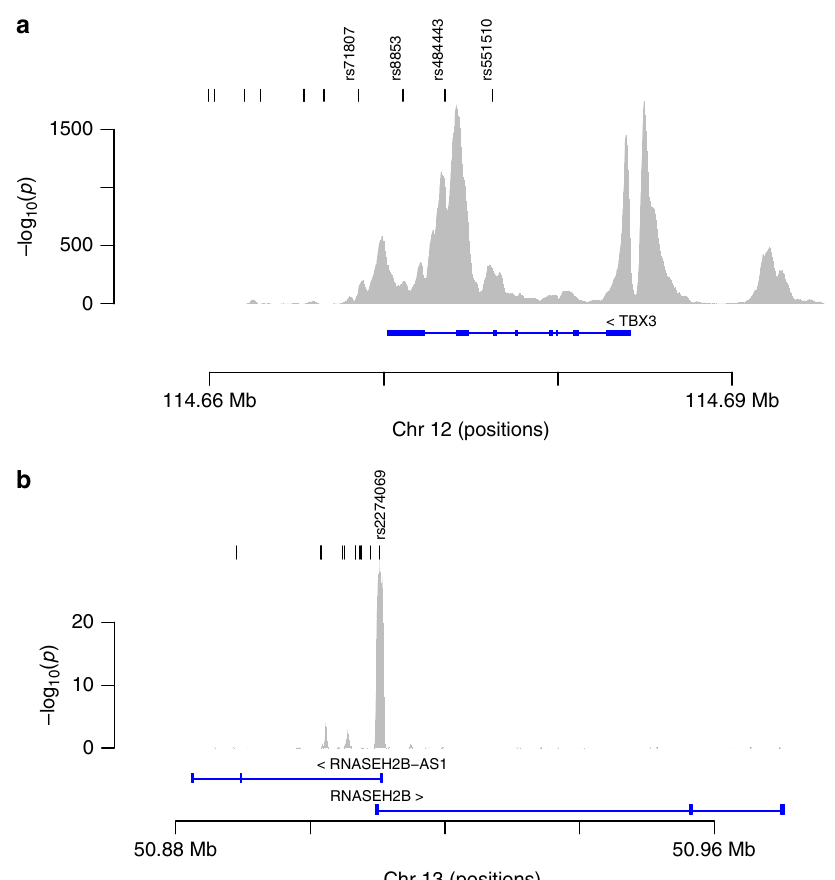
Fig. 2 GWAS variants intersecting with regulatory regions de fi ned on the basis of acetylation of histone H3 at lysine residue K27 (H3K27ac). Shown are results for two of the loci reported to associate with BPH/LUTS from an analysis of non-coding risk variants intersecting with regulatory regions de fi ned on the basis of acetylation of histone H3 at lysine residue K27 (H3K27ac), indicative of regulatory regions, in primary prostate epithelial cells. The y -axis shows the ChIP-seq signal for the H3K27ac mark represented as negative log 10 of the P -value and the x -axis shows the genomic location (hg38). The black tick marks (top of panels a and b ) indicate the position of variants found in strong LD ( r 2 > 0.8) with the lead variant, de fi ning an LD class, wherein rs numbers are shown for those residing within H3K27ac signi fi cant regions. a At 12q24.21 four variants reside within an H3K27ac marked region (rs71807, rs8853, rs484443, and rs551510). b At 13q14.3, only one variant, rs2274069, belonging to the LD class of the lead variant resides within a H3K27ac marked region. This is the promoter region for RNASEH2B , located within 500 bp from the transcription start site of the